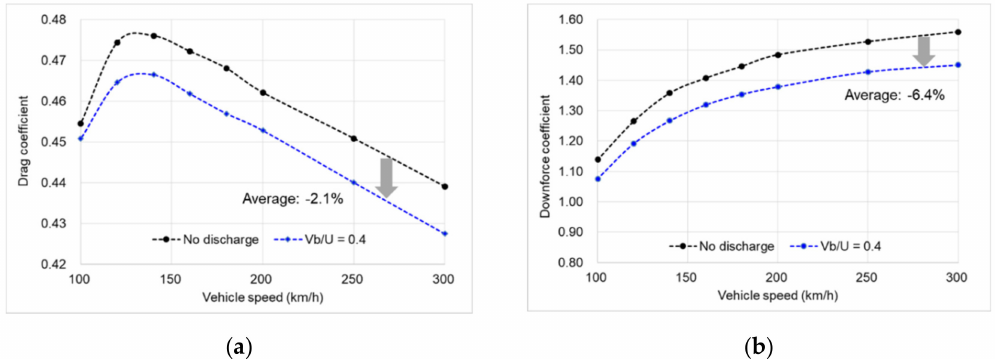
Figure 16. Comparison of aerodynamic coe ffi cients for di ff erent vehicle speeds (100–300 km / h) when discharging occurs at 75% chord; ( a ) Aerodynamic drag; ( b ) Downforce.